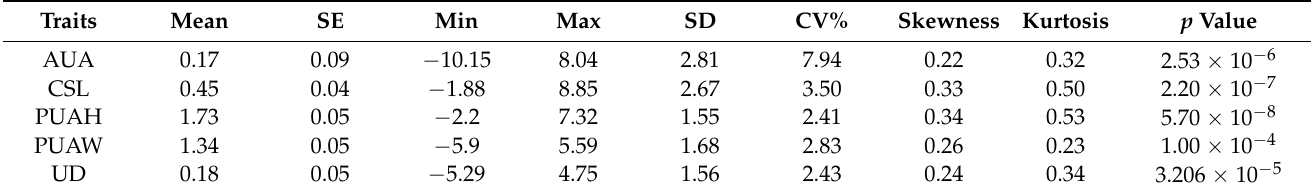
Table 1. Descriptive statistics for the adjustment of udder traits of Holstein cows (984).